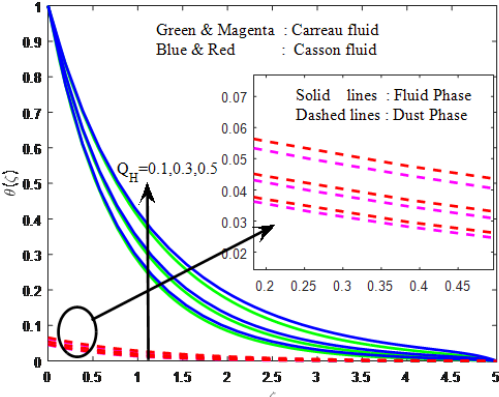
Fig. 3: Impact of M on temperature profiles.